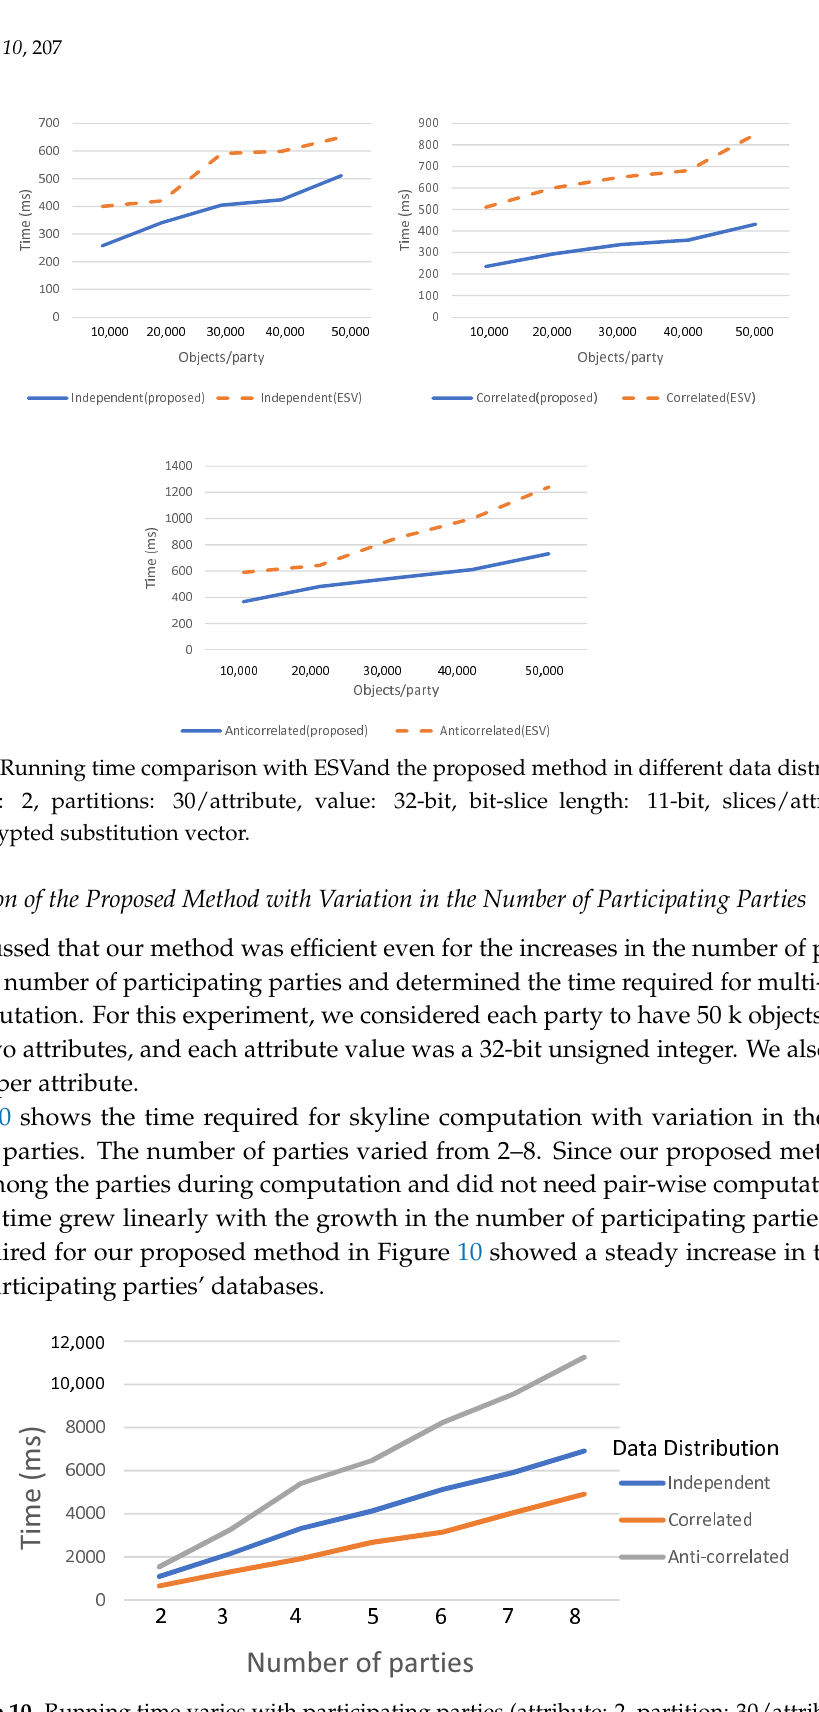
Figure 10. Running time varies with participating parties (attribute: 2, partition: